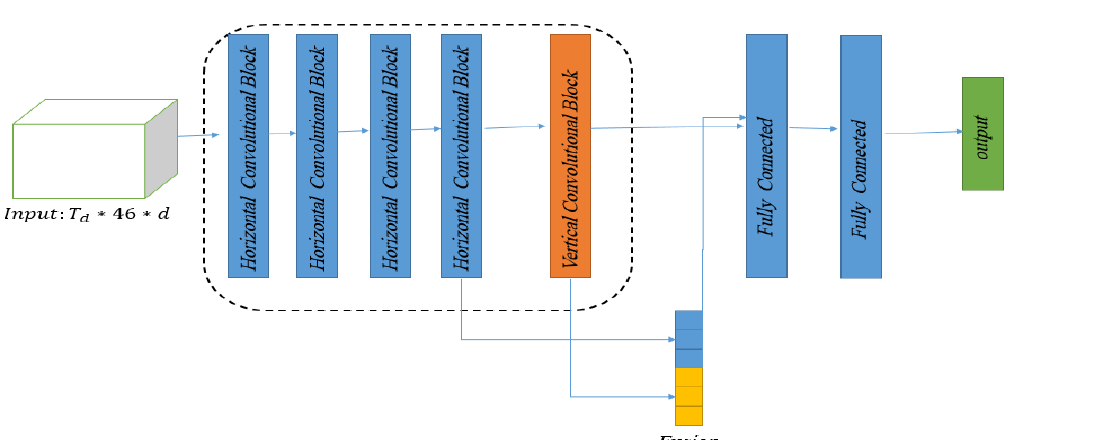
Fig. 4. Architecture of the proposed models. The dashed block (VCB) is used only in SLCNN+V.